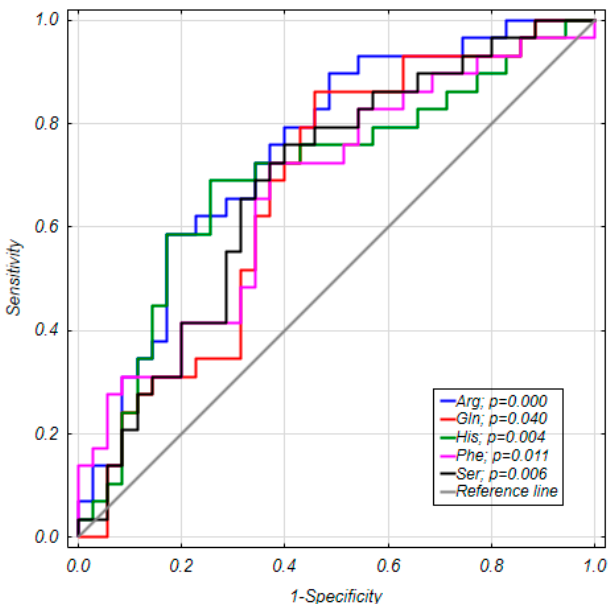
Figure 3. ROC curves for five most relevant amino acids that possess some NGT-GDM discriminative potential. p -values for null hypothesis (H0) AUC = 0.5.